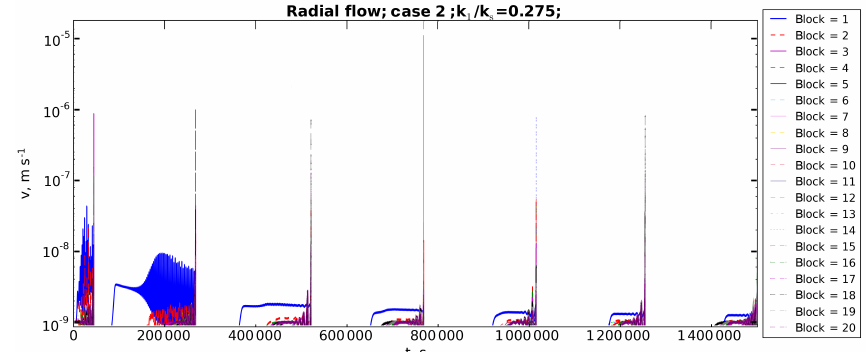
Figure 28. Seismic event occurrences in time for the system consisting of 20 blocks in Case 2.